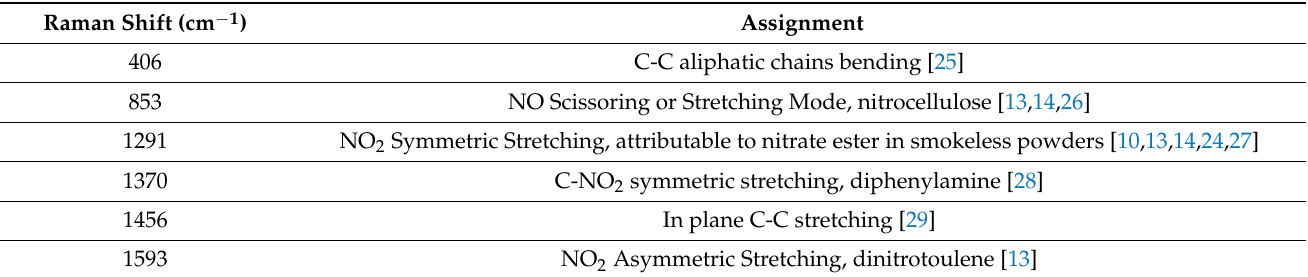
Table 2. Raman spectral peak assignments for smokeless powder spectra.